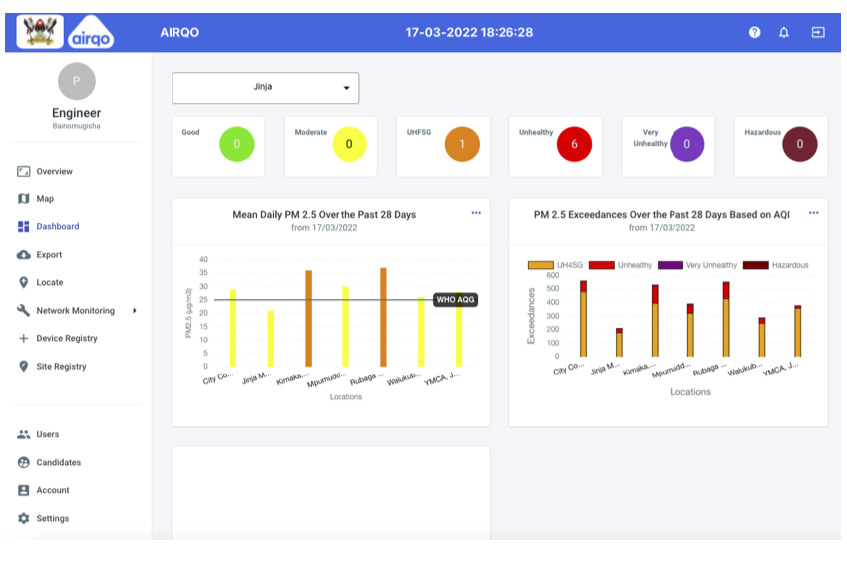
Figure 7. Digital platforms providing trends and analysis of air quality for diverse locations in a city. The tool targets decision makers in a city to gain insights on how different parts of the city compare over a specified period of